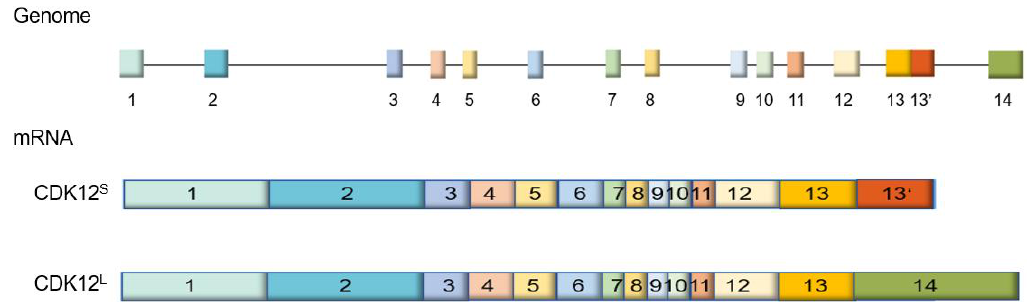
Figure 1. Genomic and messenger RNA (mRNA) structures of cyclin-dependent kinase 12 ( CDK12 ). CDK12 S : the shorter isoform of CDK12 , CDK12 L : the longer isoform of CDK12.